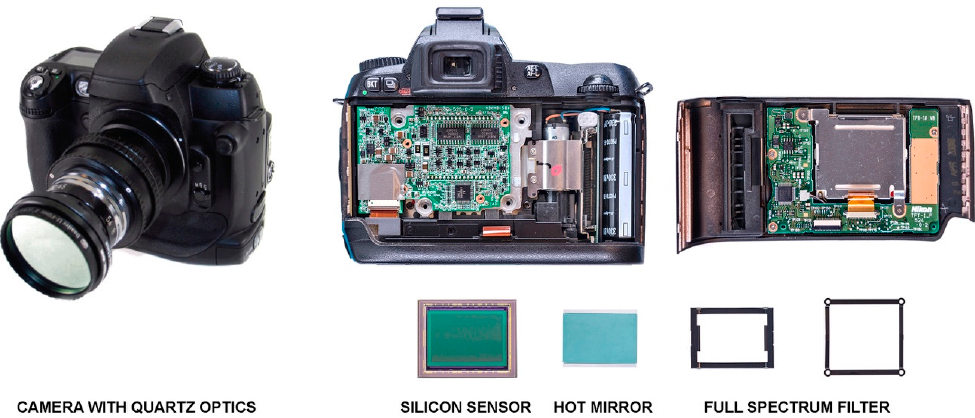
Figure 2. Multispectral capture device modified with quartz optics and Baader UV/IR-cut coupled.